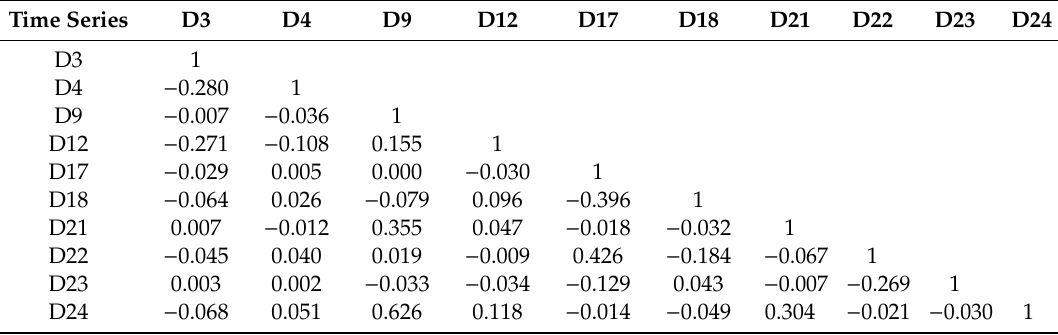
Table 9. Correlation matrix: Greece–Bulgaria interconnection